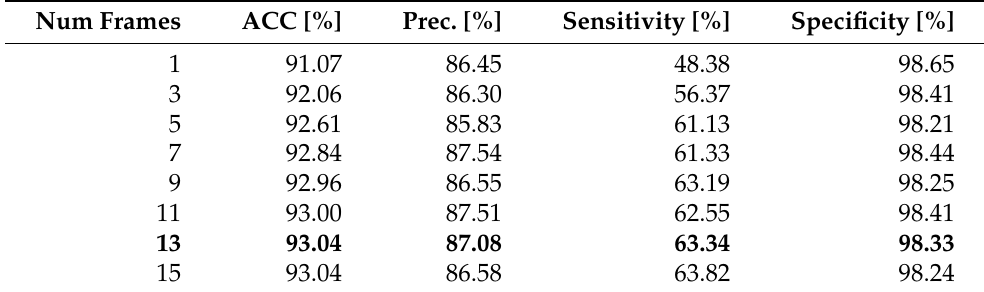
Table 5. The results of the linking model on the validation set, depending on the number of frames. The data come from the best eras. They were obtained by the fivefold cross-validation